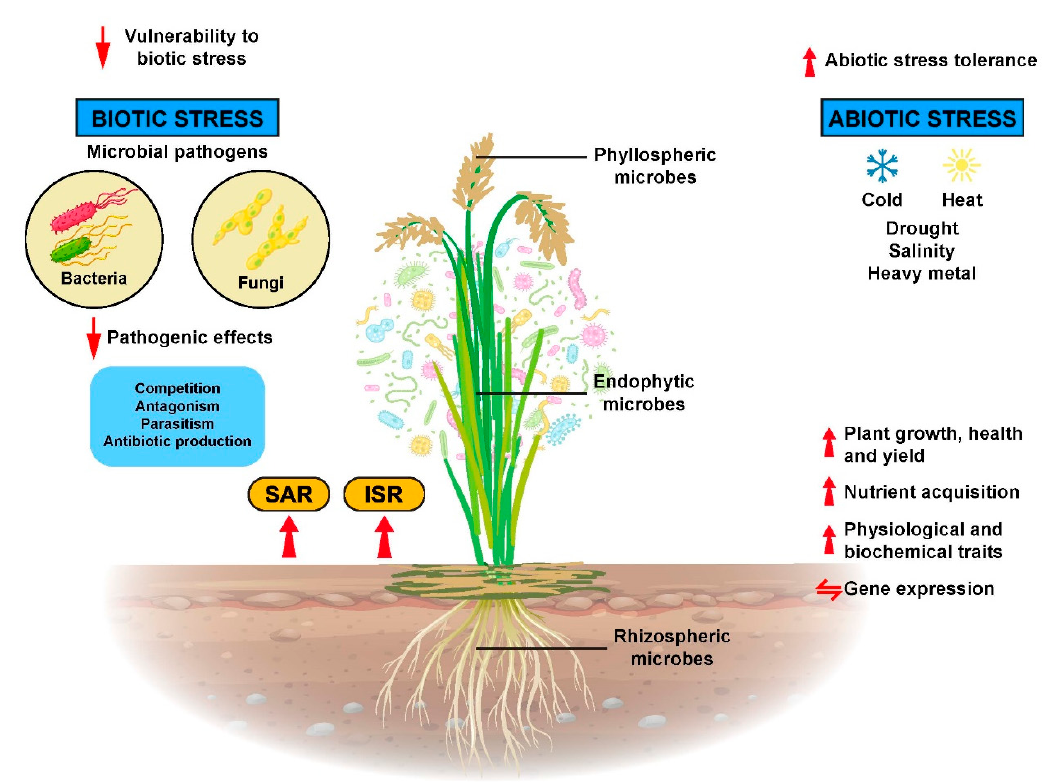
Figure 3. Microbes that are residing in, on, and inside the rice plants affected rice plant growth, physiological, biochemical, and molecular processes. Thereby, they increase rice plant growth, de- velopment, and yield as well as more resistance to biotic and abiotic